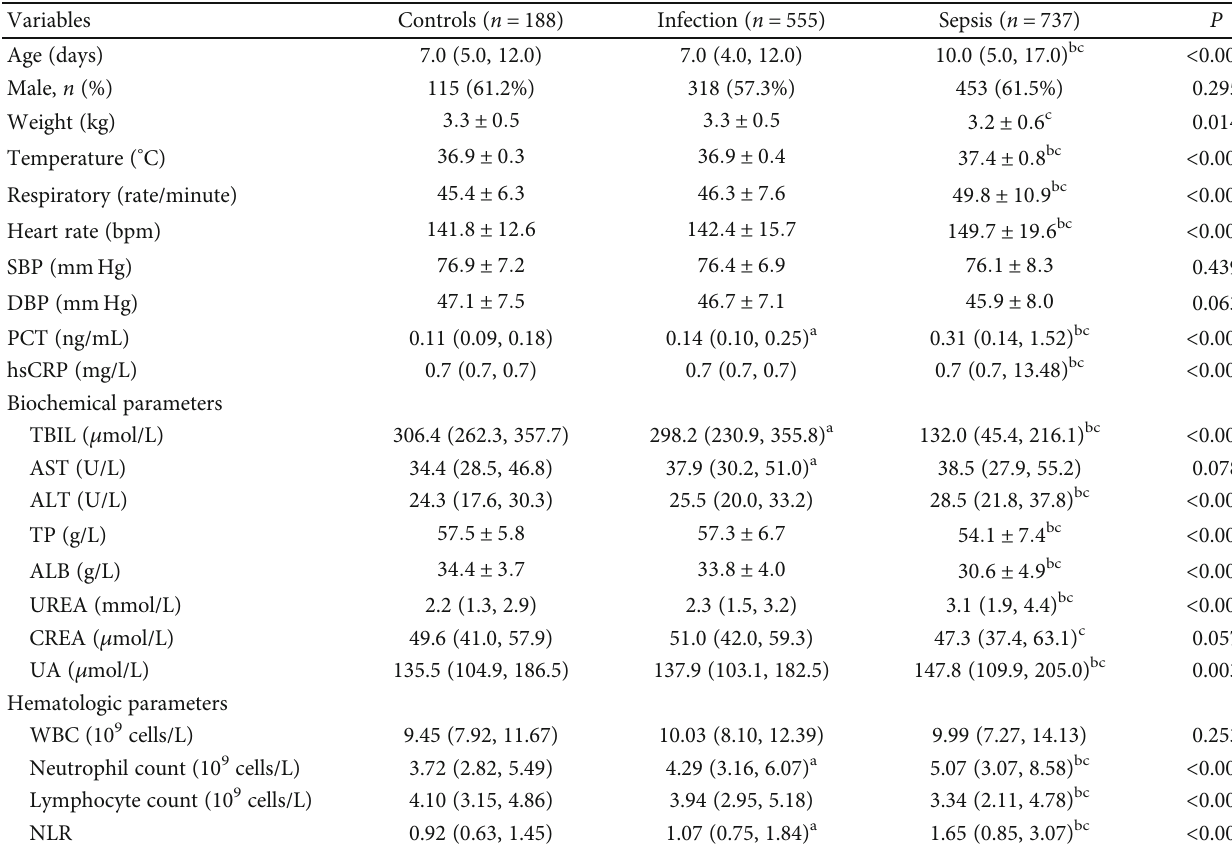
Table 1: Baseline characteristics of control, infection, and sepsis